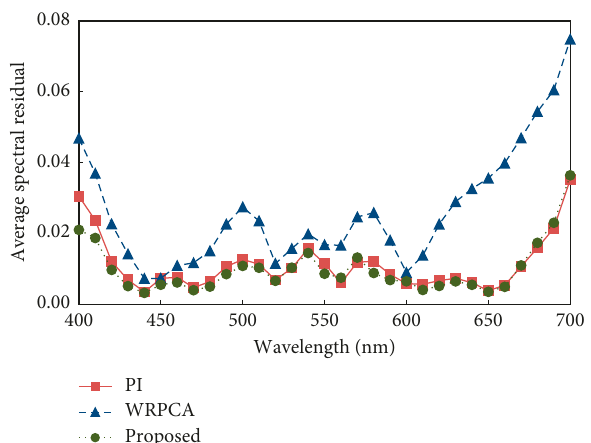
Figure 4: Average spectral residuals between recovered and measured spectra on the Vrhel dataset.